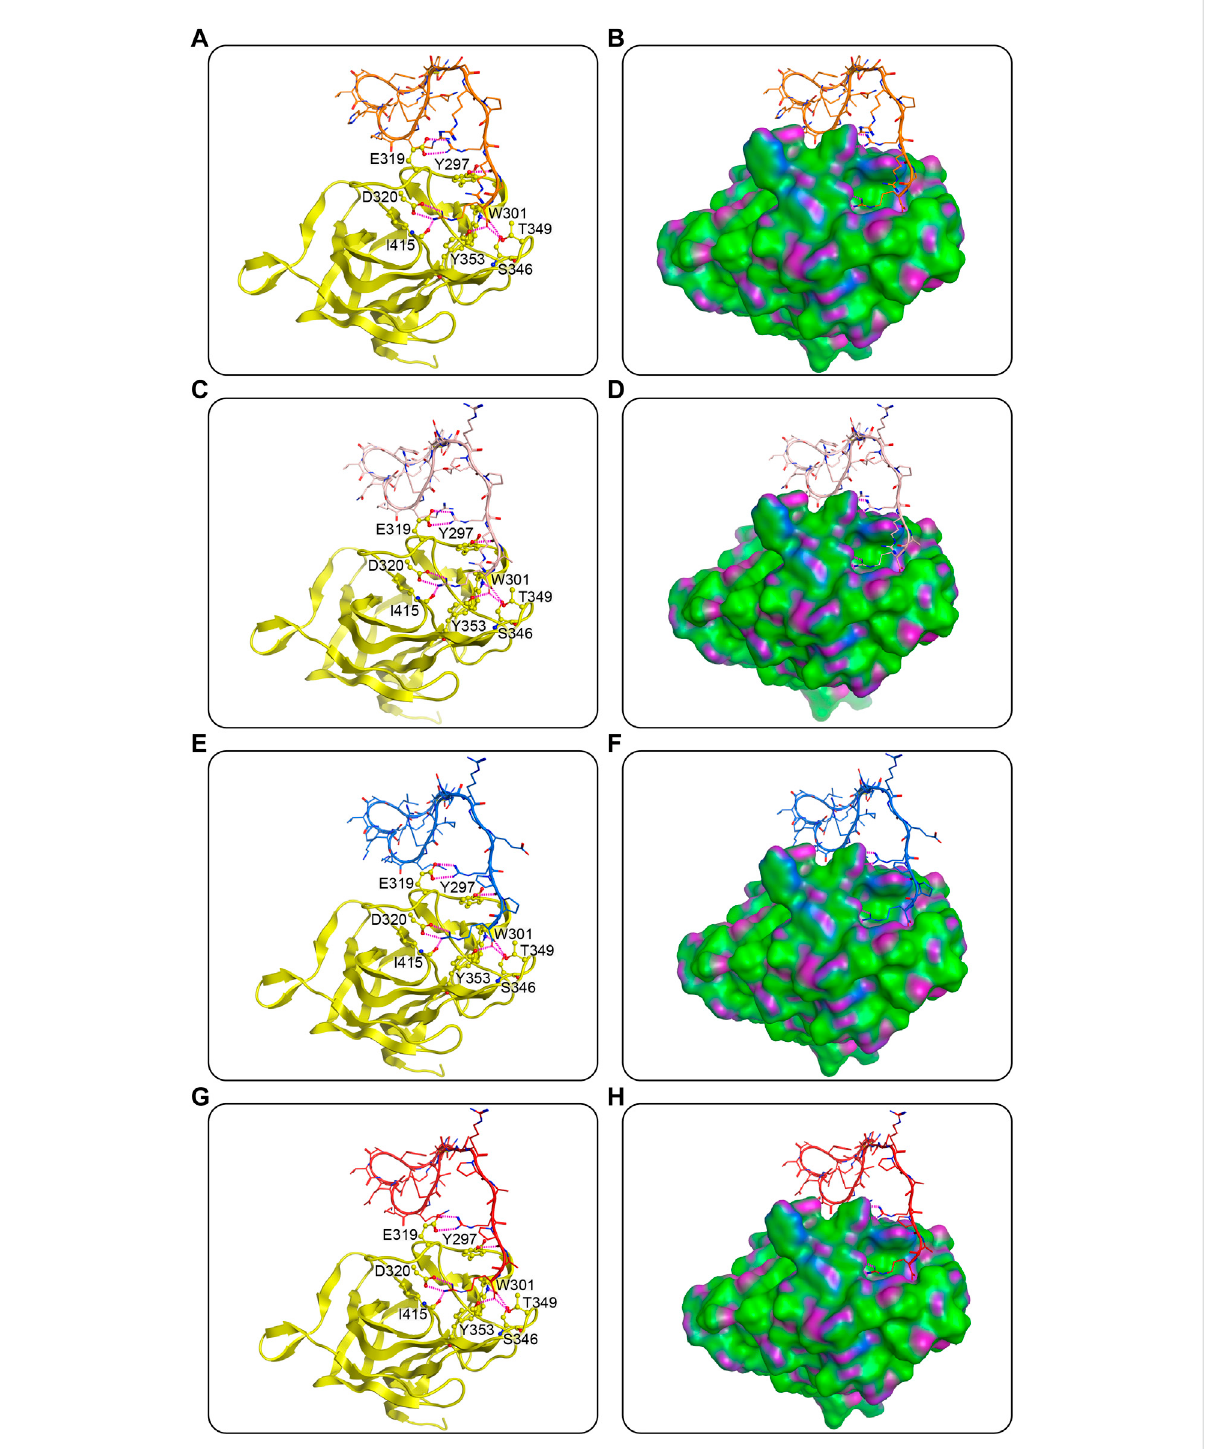
FIGURE 4 Predicted docking poses of MNs 1-4 at the NRP1-BD. (A) , (C) , (E) , and (G) are MNs 1-4, respectively, and (B) , (D) , (F) , and (H) are their corresponding surface plots. Peptides are represented by different colors (orange for MN-1, pink for MN-2, blue for MN-3, and red for MN-4), and NRP1-BD is color-coded by yellow. The hydrogen bonds were indicated by purple dotted lines. The surface of NRP1-BD is plotted by H-bonding (purple), hydrophobicity (green), and mild polar (blue)